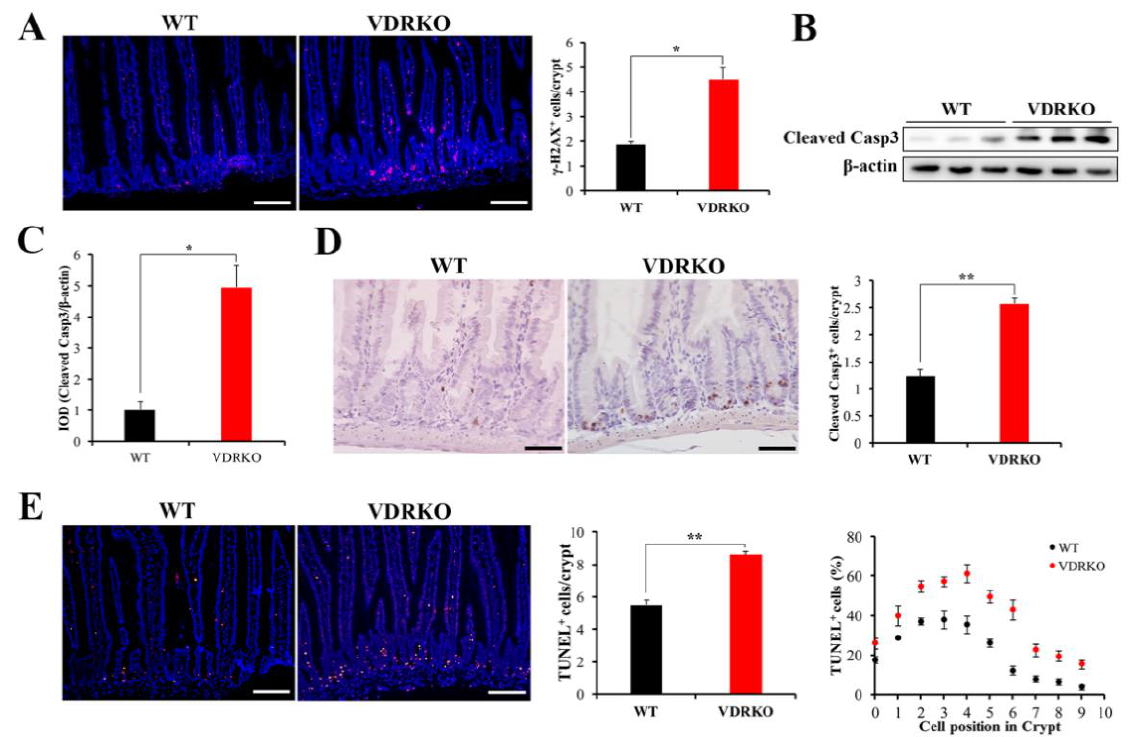
Figure 5. VDR deficiency aggravates IR-induced DNA damage and crypt stem/progenitor cell apoptosis. ( A ) Representative IF images showing the γ H2AX expression at 5 h post 12 Gy IR and quantification of γ H2AX + cells in crypts. n = 6 in each group. Scale bar, 100 μm. ( B ) Cleaved Casp3 was evaluated in intestine tissues of mice at 5 h after IR by WB. ( C ) The Cleaved Casp3 expression was quantitatively analyzed. ( D ) Representative IHC images of Cleaved Casp3 at 5 h after 12 Gy IR and quantification of Cleaved Casp3 + cells in crypts. n = 6 in each group. Scale bar, 50 μm. ( E ) Representative IF images of TUNEL staining of WT and VDRKO mice at 5 h after 12 Gy IR. Quantification of TUNEL + cells/crypt and their positions in crypts. Scale bar, 100 μm. n = 6 in each group. Values are means ± SD. * p < 0.05, ** p < 0.01.